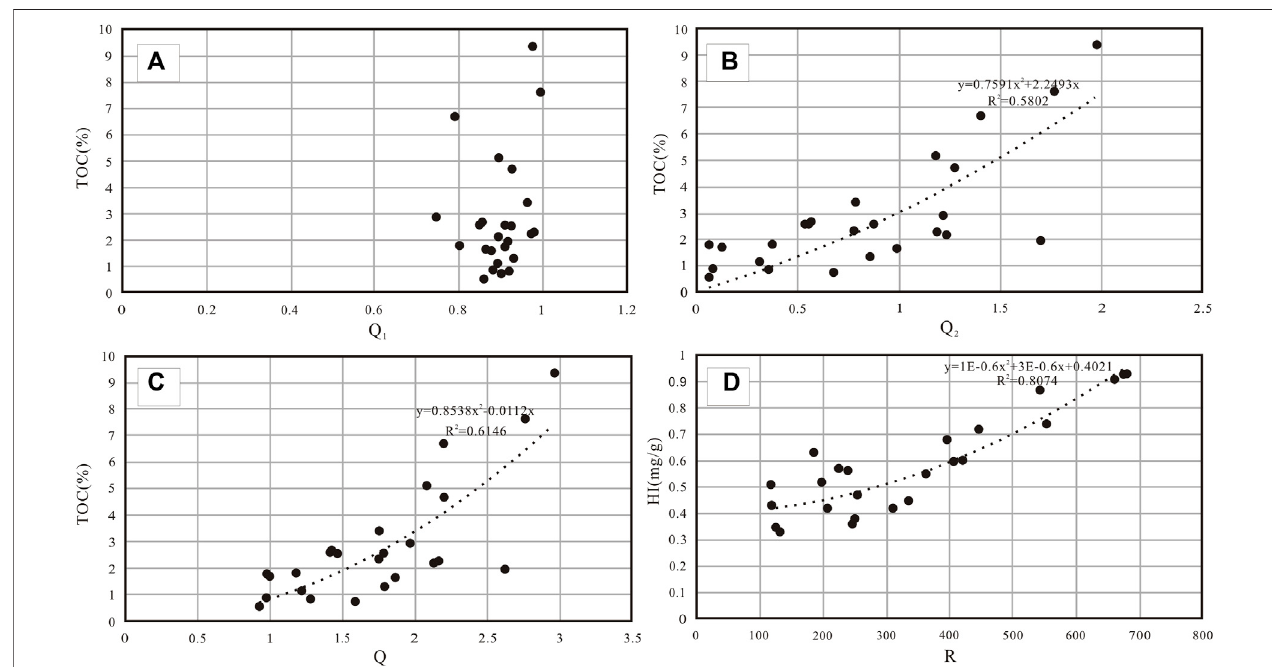
FIGURE10| Crossplots: (A) Q1versusTOC, (B) Q2versusTOC, (C) QversusTOC,and (D) RversusHI,givinganindicationfortheoriginsoforganicmatterinthe Chang-7 shale in the study